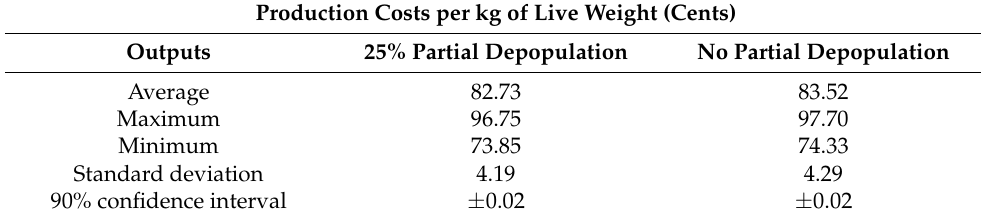
Table 2. Production costs per kg of live weight produced in the 25% partial depopulation scenario and no partial depopulation scenario.